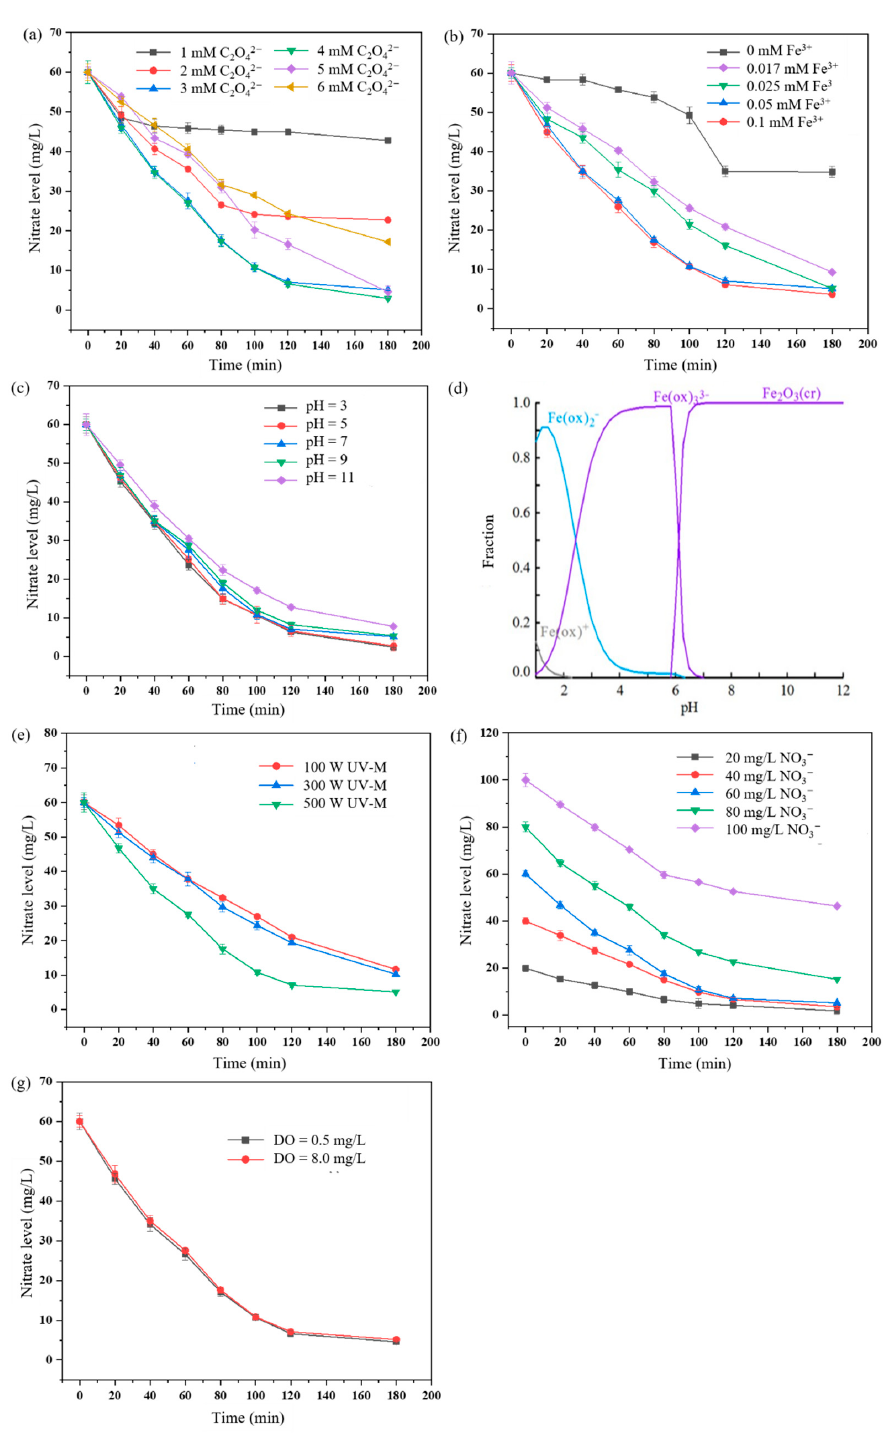
Figure 4. The effect of ( a ) initial oxalic acid levels, ( b ) initial iron dosage, ( c ) initial solution pH, ( d ) the distribution of iron–oxalate complexes at various pHs, ( e ) lamp power, ( f ) initial nitrate concen- trations, and ( g ) dissolved oxygen (DO) on NO 3 ‒ reduction in the UV/C 2 O 42 ‒ /Fe 3+ process. Experi- mental conditions: [NO 3 ‒ ] 0 = 60 mg/L, [Fe 3+ ] 0 = 0.05 mM, I 0 = 10.2 mW/cm 2 (wavelength = 365 nm), [DO] 0 = 0.5 ± 0.1 mg/L, pH ini. = 7.0 ± 0.2, and T = 25 ± 0.5 ºC in ( a ), [NO 3 ‒ ] 0 = 60 mg/L, [H 2 C 2 O 4 ] 0 = 3 mM, I 0 = 10.2 mW/cm 2 (wavelength = 365 nm), [DO] 0 = 0.5 ± 0.1 mg/L, pH ini. = 7.0 ± 0.2, and T = 25 ±